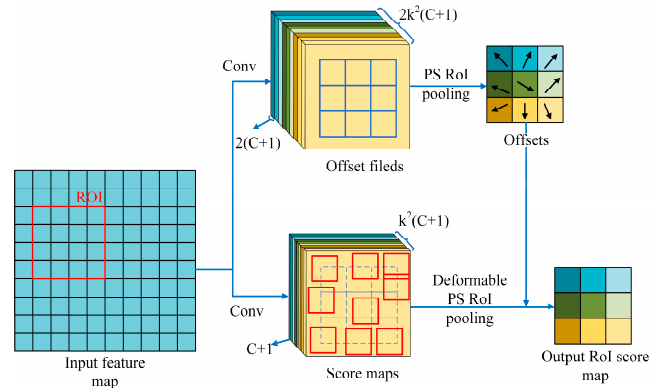
Figure 9. Illustration of deformable position-sensitive (PS) RoI